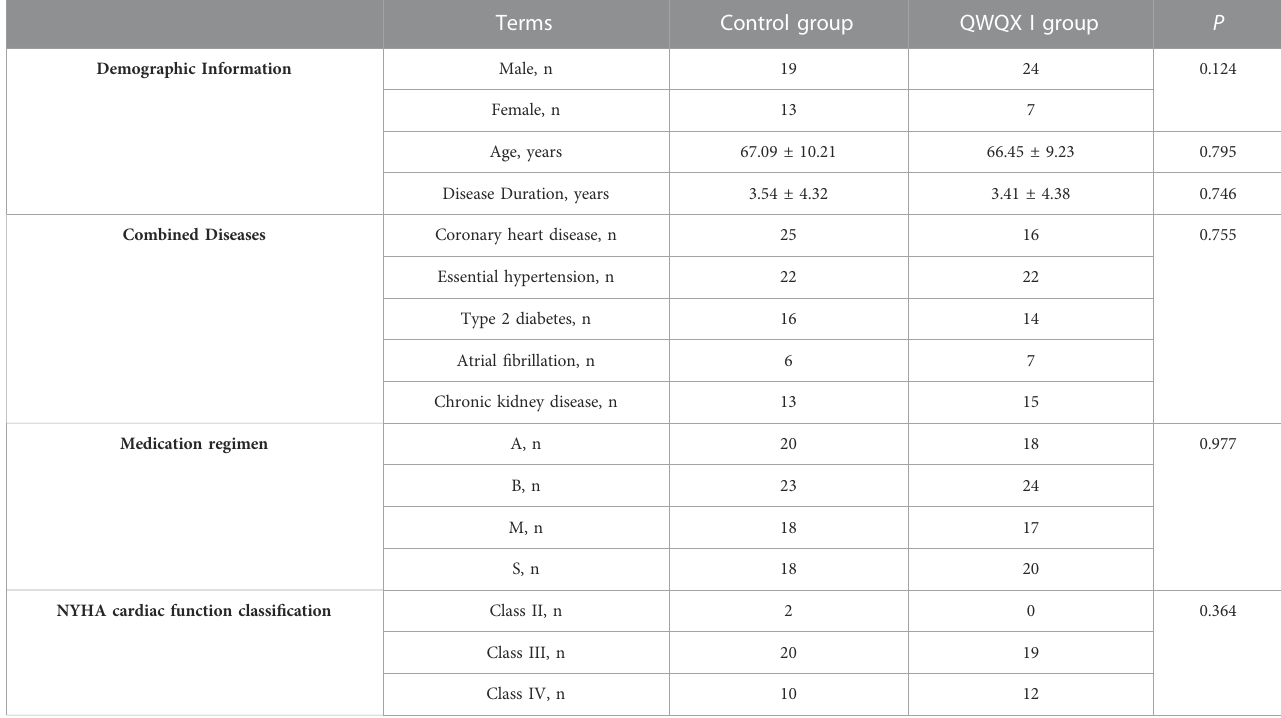
TABLE 1 Baseline Characteristics of Patients in control or QWQX I